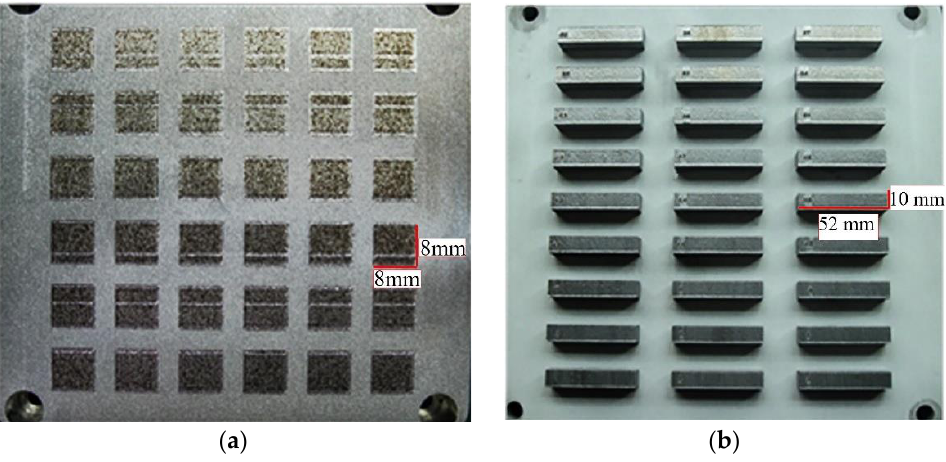
Figure 5. Photograph of the samples manufactured by SLM process: ( a ) Single layer samples; ( b ) Cuboid samples (Multiple layers).